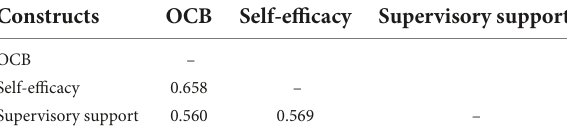
TABLE 4 Discriminant validity (HTMT